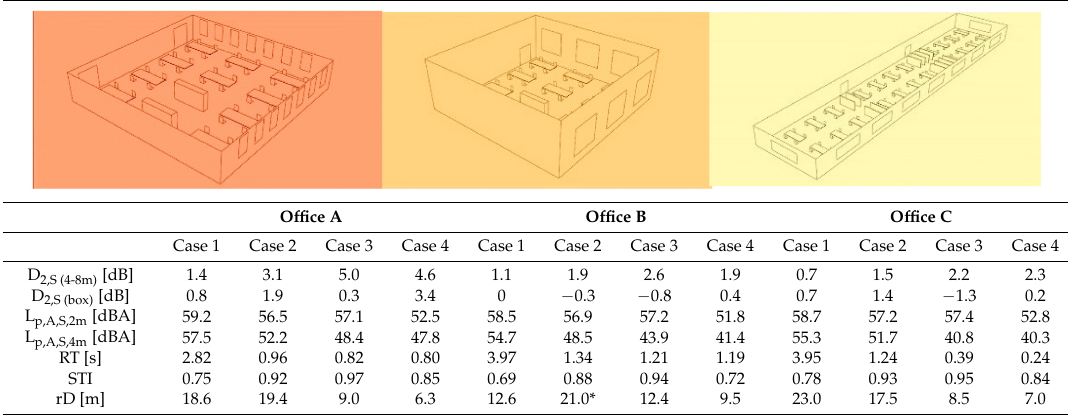
Figure 11. Analysis of spatial decay of STI in all types of offices analyzed, referred to as configuration 4. Table 6. Summary table of results obtained from the simulations of 24 types offices; the value of STI is referred to the worker placed in front of the speaker (opposite working position); the asterisk (*) means that the dimension found for the distraction distance is greater than the maximum length of the